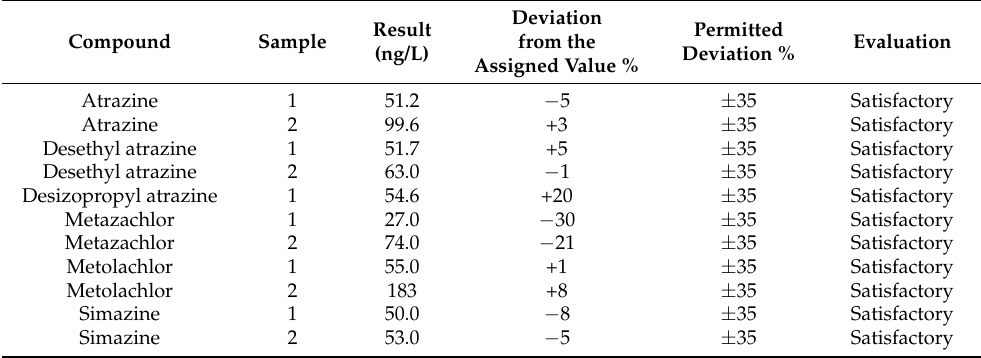
Table 1. Proficiency test